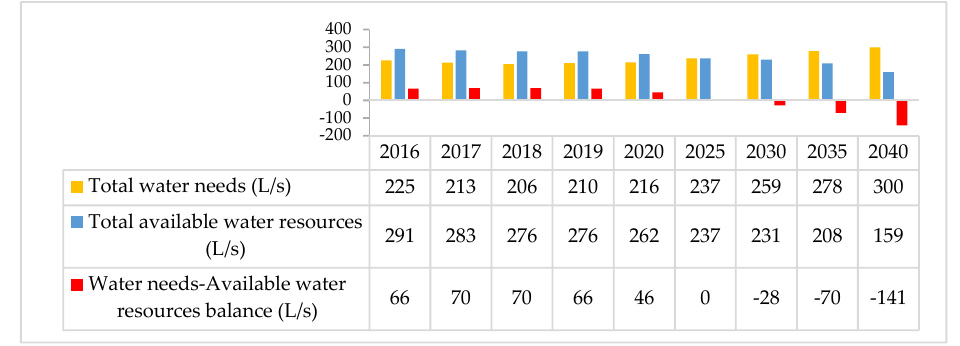
Figure 5. Estimation of drinking water needs—available water resources balance sheet of Taourirt municipality (Current scenario).